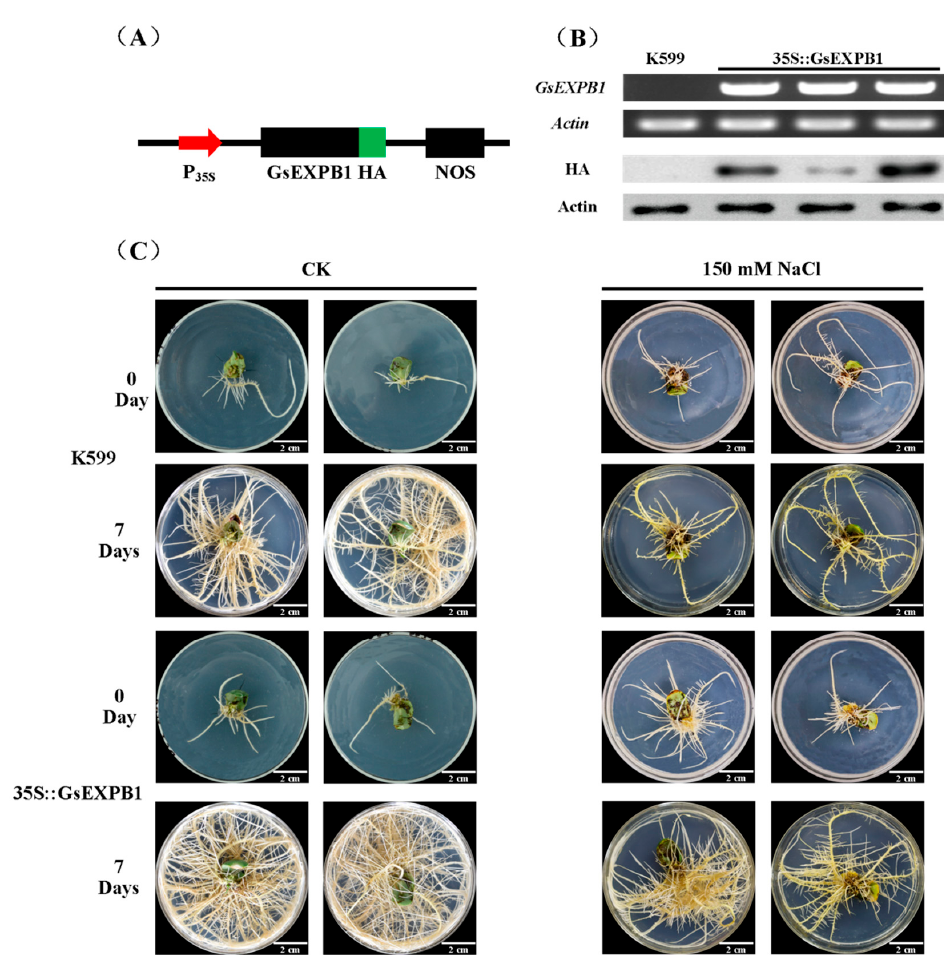
Figure 10. Overexpression of GsEXPB1 significantly promoted cultivated soybean hairy roots growth and salt stress tolerance. ( A ) Construction of expression vector, P 35S indicates CaMV35S promoter, HA indicates HA protein tag, NOS indicates terminator. ( B ) Detection results of gene transcription and protein expression in transgenic hairy roots. ( C ) Phenotypic observation of hairy roots overexpressing GsEXPB1 under normal growth conditions and salt stress, bar = 2 cm.